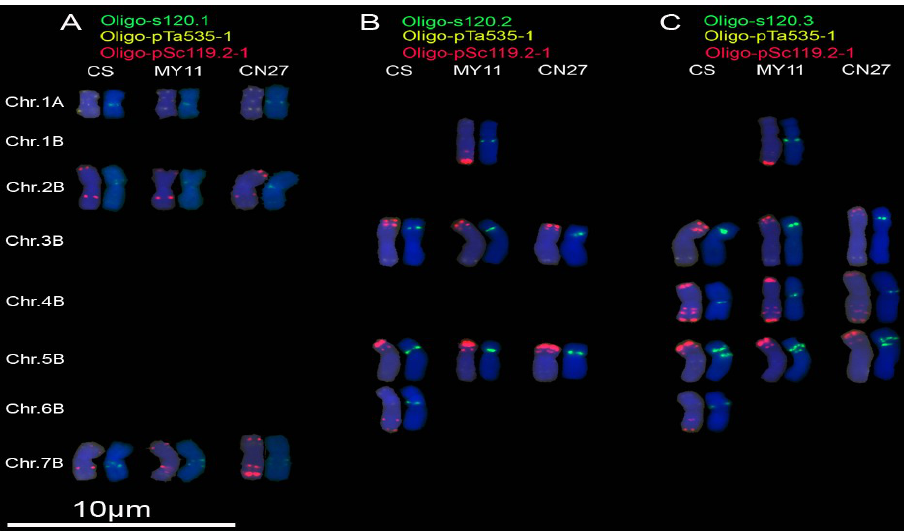
Figure 2. Oligo-s120.1 ( green ), Oligo-s120.2 ( green ) and Oligo-s120.3 ( green ) combined with Oligo-pTa535-1 ( yellow ) and Oligo-pSc119.2-1( red ) were used as probes for ND-FISH analysis of root tip metaphase chromosomes of wheat varieties Chinese Spring (CS), Mianyang 11 (MY11), and Chuannong 27 (CN27): ( A ) Oligo-s120.1 hybridization patterns; ( B ) Oligo-s120.2 hybridization patterns; and ( C ) Oligo-s120.3 hybridization patterns. Only the chromosomes with strong or clear signals of Oligo-s120.1, Oligo-s120.2 or Oligo-s120.3 were cut and pasted. Chr.: chromosome. Chromosomes were counterstained with DAPI ( blue ).